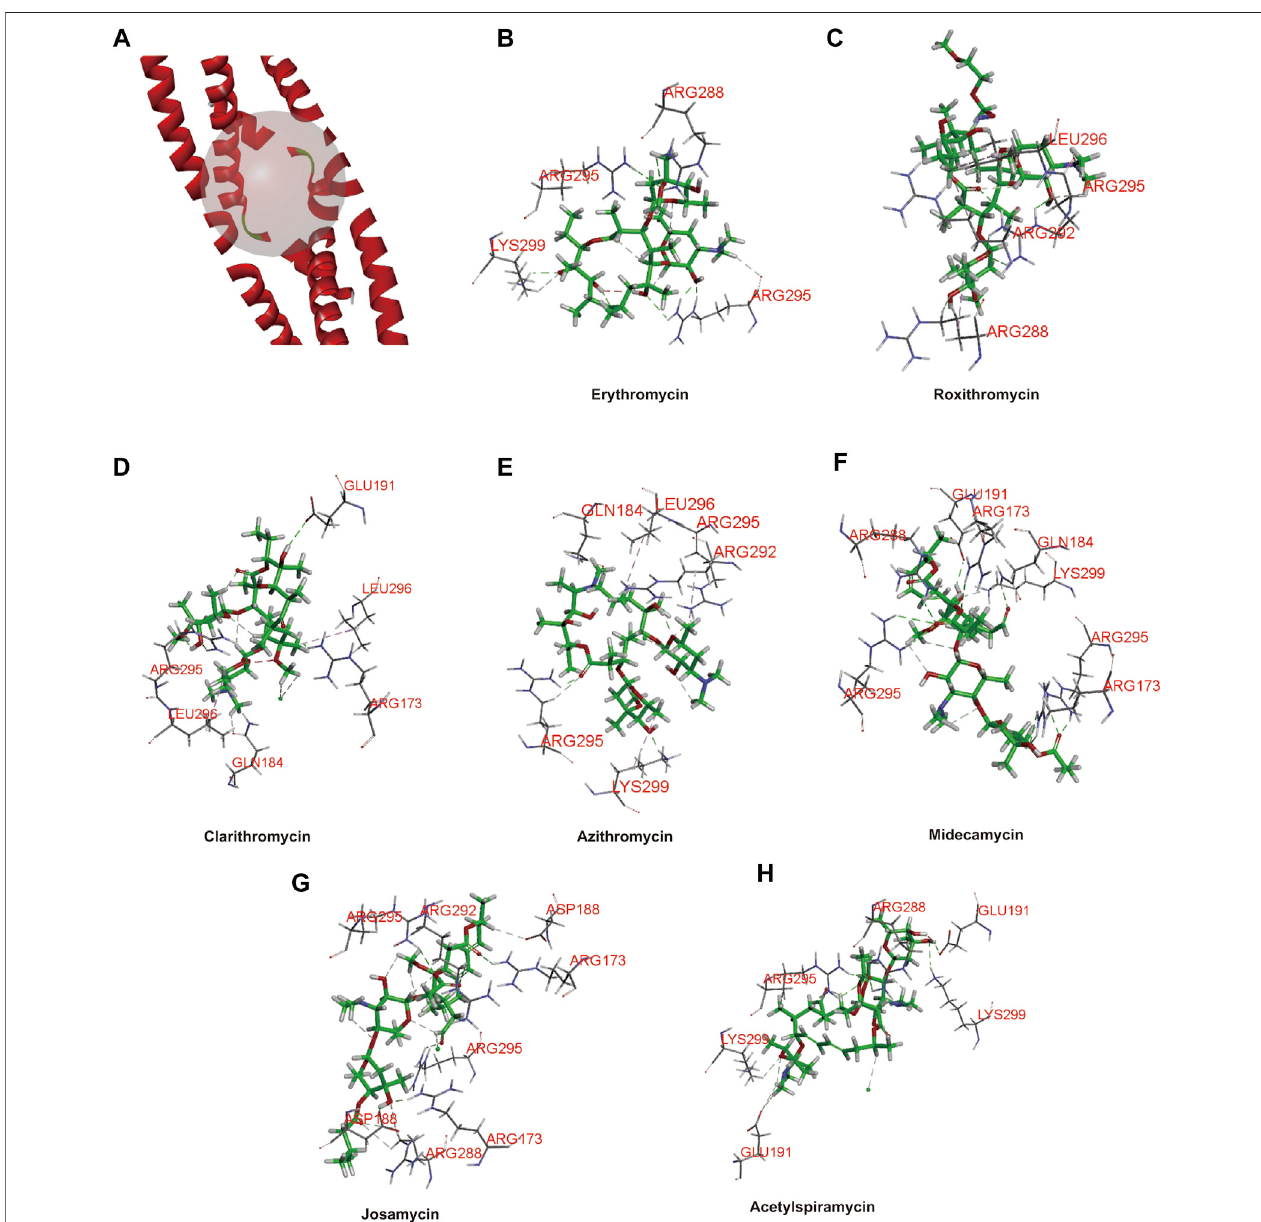
FIGURE 1 | Three-dimensional (3D) structure model of protein ligand docking. (A) Active site of the FosB/JunD bZIP domain. (B – H) Docking interactions of erythromycin (B) , roxithromycin (C) , clarithromycin (D) , azithromycin (E) , midecamycin (F) , josamycin (G) , and acetylspiramycin (H) with the FosB/JunD bZIP domain. The representative images indicate the optimum docking poses in this